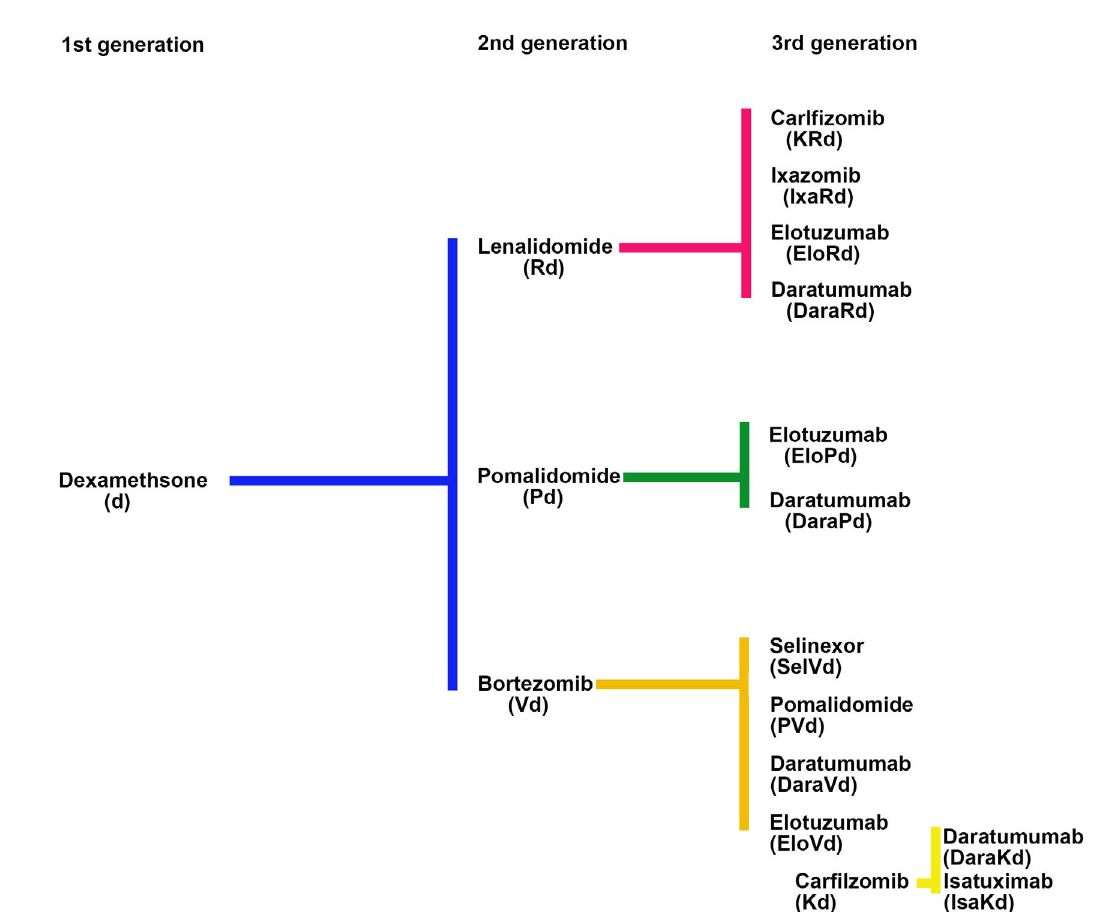
Figure 2 . History of comparator arms in relapsed refractory trials (1-3 prior